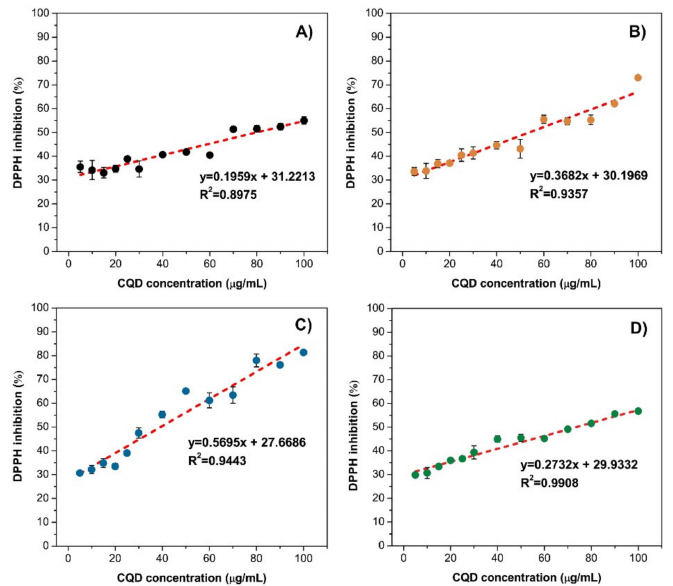
Figure 5. Antioxidant activity of prepared CQDs using DPPH free radical assay for ( A ) pure CQD; ( B ) CQD@Gly; ( C ) CQD@Arg, and ( D ) Citrus clementina